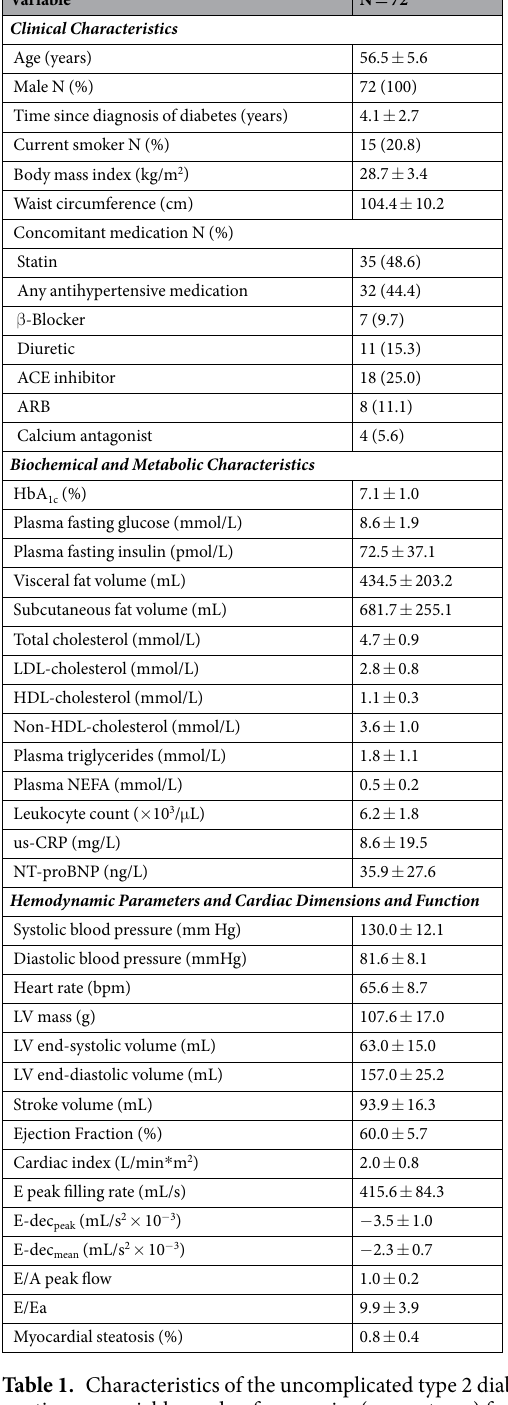
Table 1. Characteristics of the uncomplicated type 2 diabetes patients. Data are presented as mean ± SD for continuous variables and as frequencies (percentages) for categorical variables. ACE: Angiotensin-converting enzyme; ARB: angiotensin receptor blocker; HbA 1c : Glycated haemoglobin. For other abbreviations see the